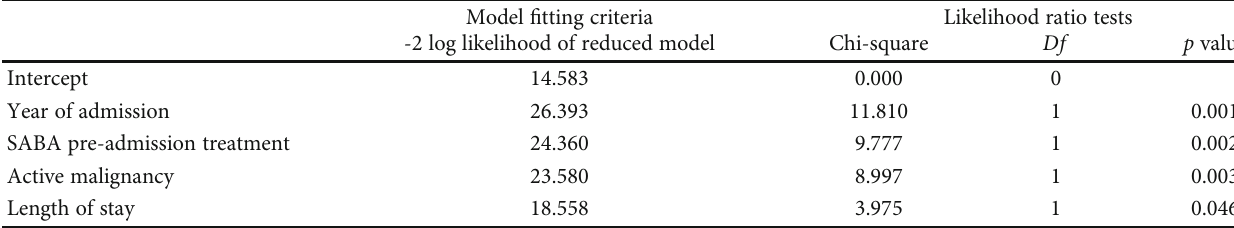
Table 6: Predictors of inpatient mortality identi fi ed by the logistic regression model.